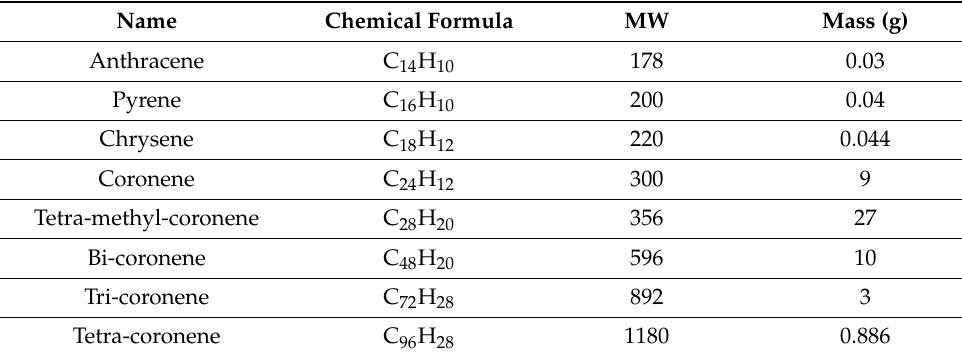
Table 6. Mass distribution of a 50 g pitch sample at room temperature subjected to the calculations in the present work.